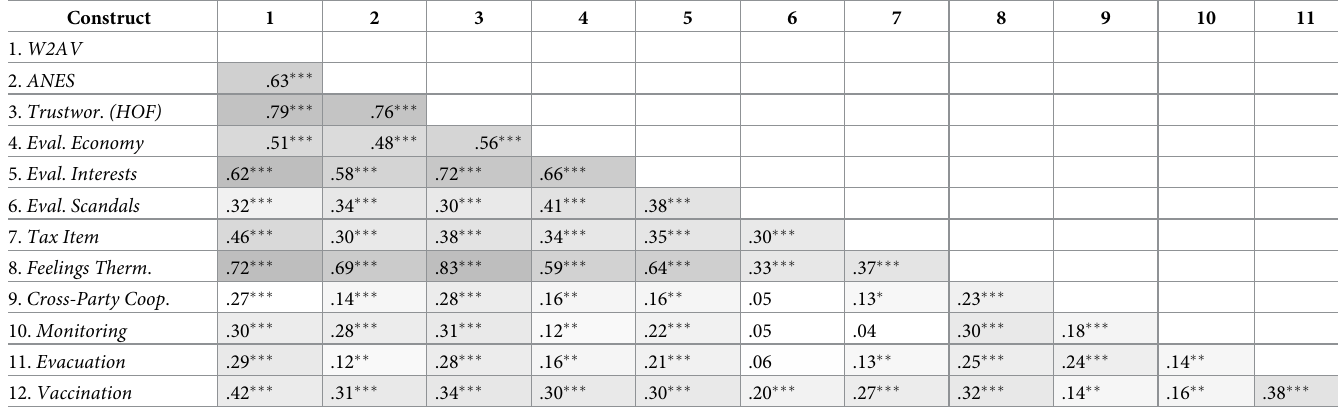
Table 3. Saturated model variable correlations heat